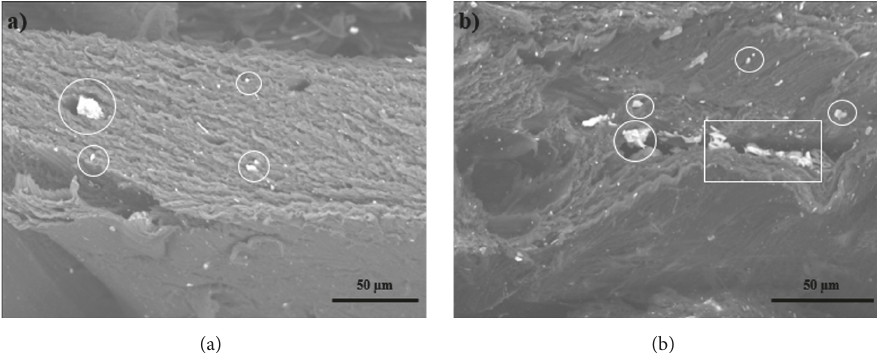
Figure 7: SEM micrographs of tensile test fracture surfaces of ABS:SEBS-g-MA loaded with (a) 10% P-glass and (b) 20% P-glass.